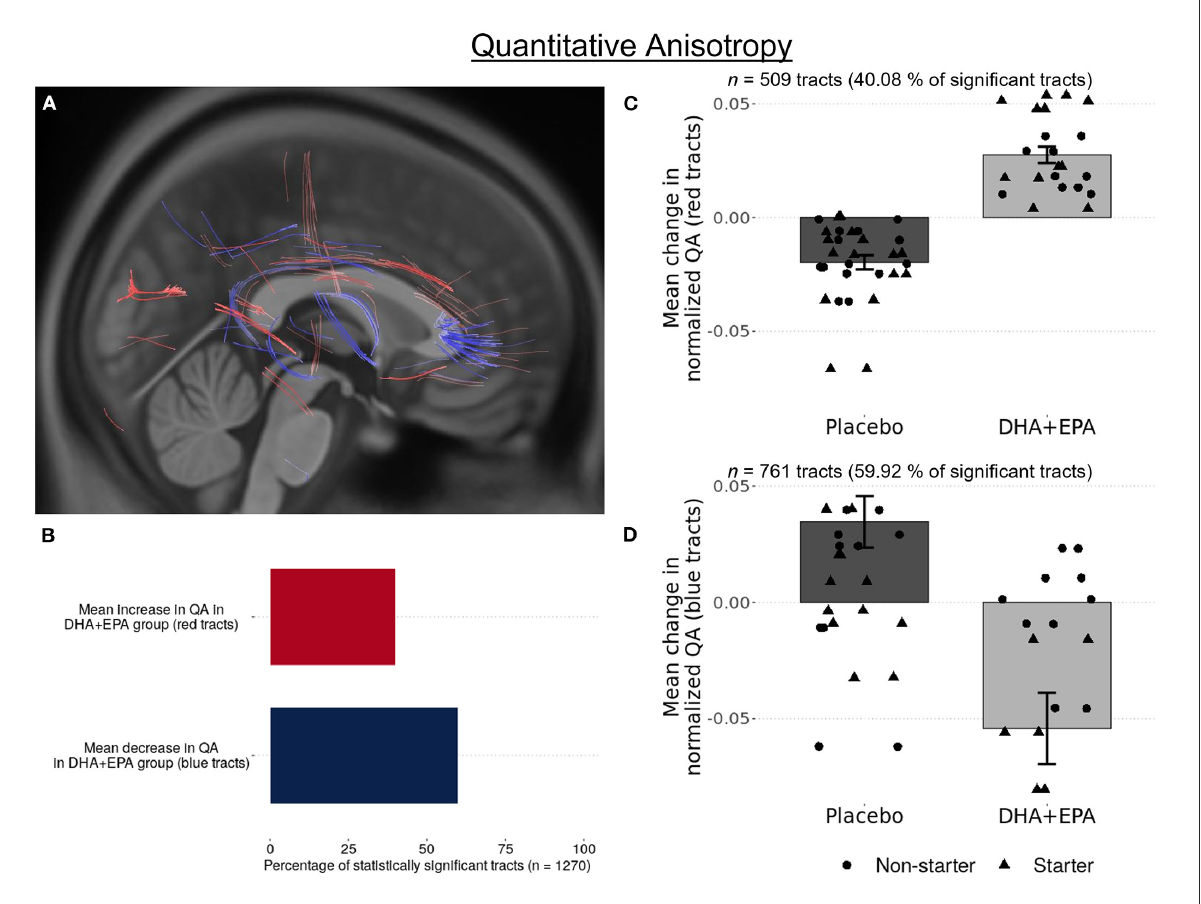
FIGURE3 Group-wise differences in white matter structural connectivity following treatment. Quantitative anisotropy (QA) was used to create local connectome fingerprints to track white matter changes. A total 1,270 survived multiple comparisons correction of (FDR corrected p < 0.003). 40.08% of these tracts showed an increase in QA for participants receiving DHA + EPA and a decrease in QA for participants receiving placebo ( A red-colored tracts; B,C ). 59.91% of the identified tracts exhibited increased QA in participants receiving placebo and a decrease in QA for those receiving DHA + EPA ( A blue-colored tracts; B,D